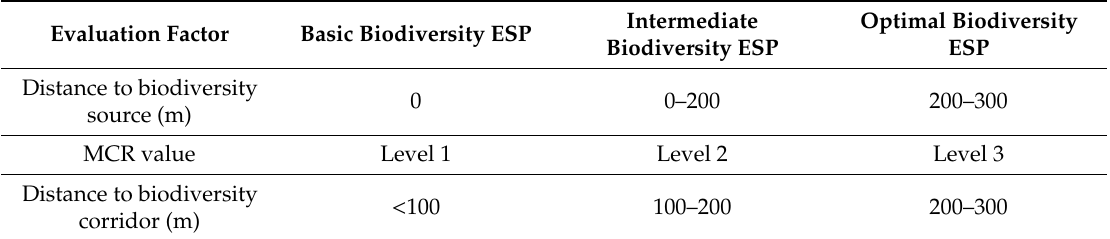
Figure 4. ( a ) Nighttime light in Quanzhou city; ( b ) Revised resistance surface. Table 9. Criteria for biodiversity ESP identification.